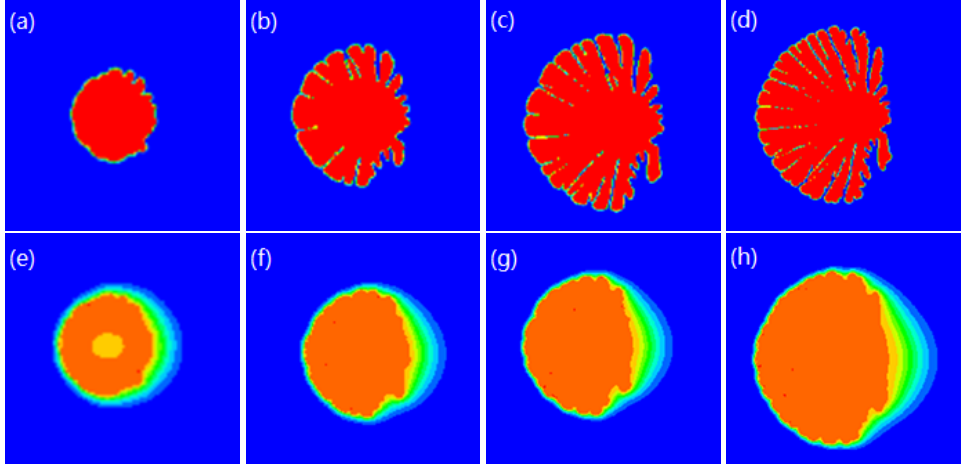
Figure 11. When K 0 = 1.4, v x = 0, v y = 1.5, the simulated spherulite morphology and the